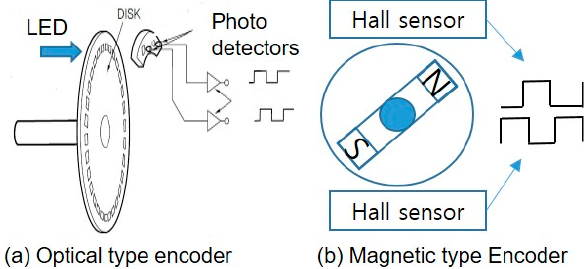
Figure 3. Two types of the encoder for exercise data acquisition (DAQ) device.